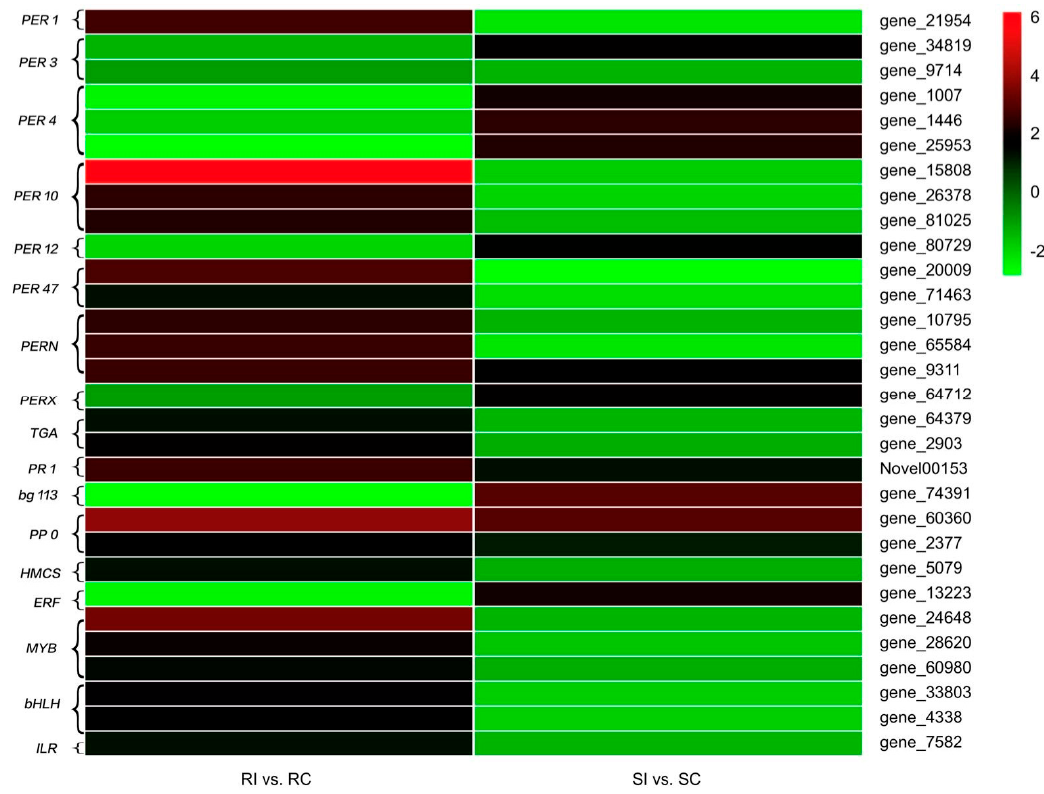
Figure 7. Comparison of the resistance-related genes expressed in the resistant (R) and susceptible (S) genotype in response to Meloidogyne incognita infection using heatmaps. The colored bars represent the log 2 fold change in the RI vs. RC and SI vs. SC libraries.